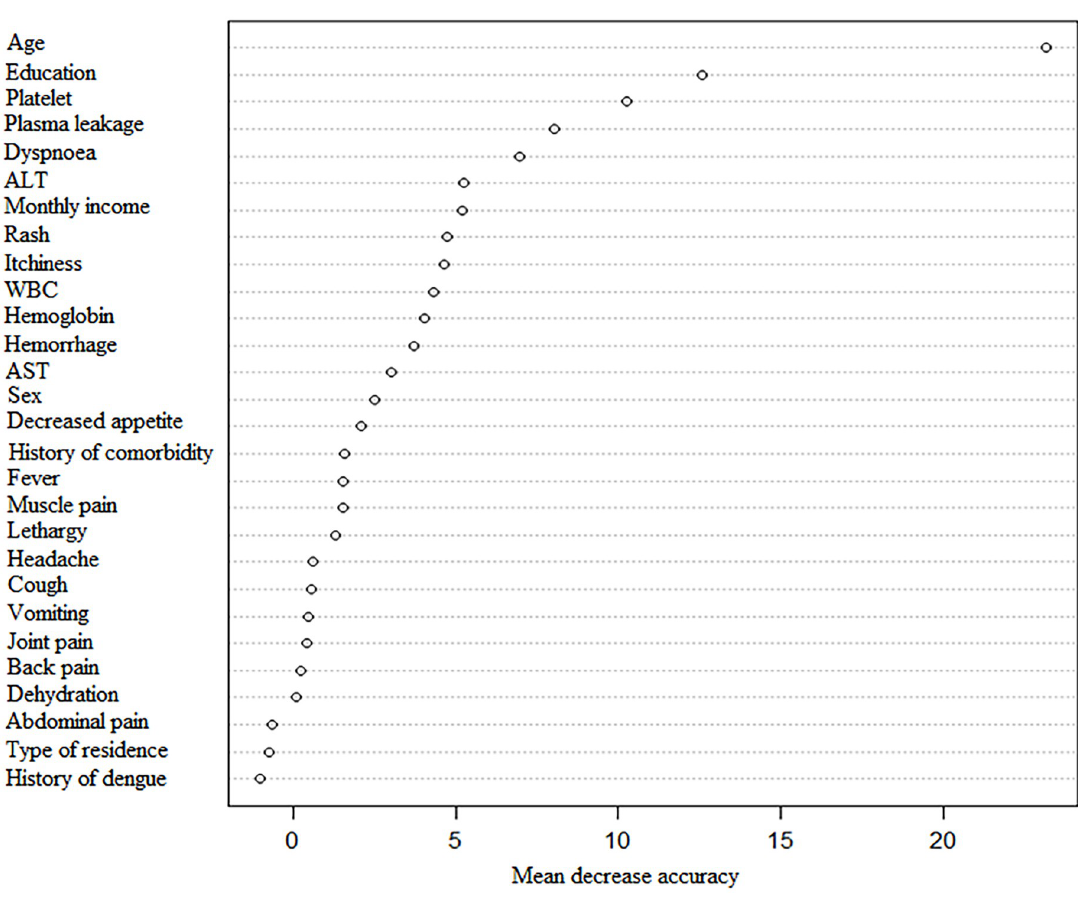
Fig 2. The random forest (RF) model identified the important predictors for predicting severe